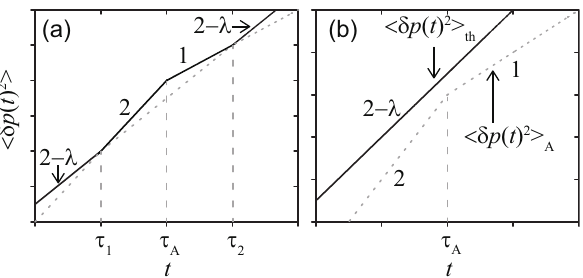
(cid:10) (cid:11) Figure 2. Sketches of MSDs δ p ( t ) 2 for a simple probe in a viscoelastic media at double-logarithmic scales. The active noise with ( a ) strong k B TG ( τ A ) < A , or ( b ) weak k B TG ( τ A ) > A magnitude, respectively. The same parameters as those in Figure 1 are